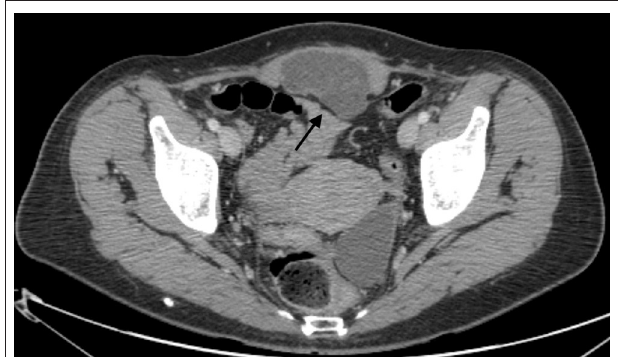
FIGURE 1 | A solid, poorly vascularized mass, measuring 83 × 63 × 36mm, with thin septa, is apparent in the rectus muscle of the abdomen in the suprapubic area